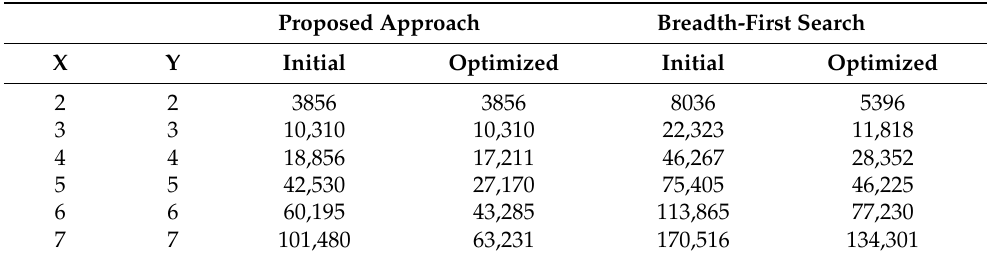
Table 4. Comparison of basic breadth-first search with the proposed modified method, objective- function values (lower is better) for initial and 2-opt optimized